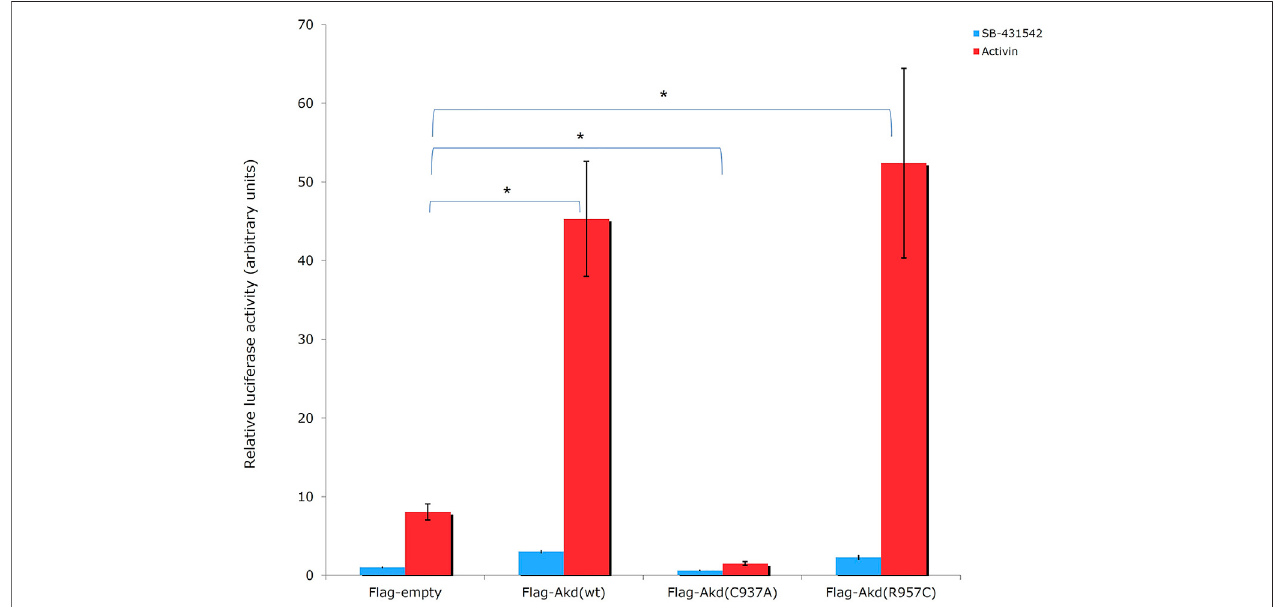
FIGURE8| LuciferaseCAGA 12 reporterassayvalues.Activin:activatoroftheTGF- β pathway.SB-431542:inhibitorofTGF- β superfamilytypeIactivinreceptor-like kinasereceptors.C937Aisaligasedefectivemutant,whichformsmixeddimers(Erkeretal.,2013)withtheendogenouswtproteinleadingonsuppressionofwtfunction in HEK293T cells (Sharma et al., 2011).